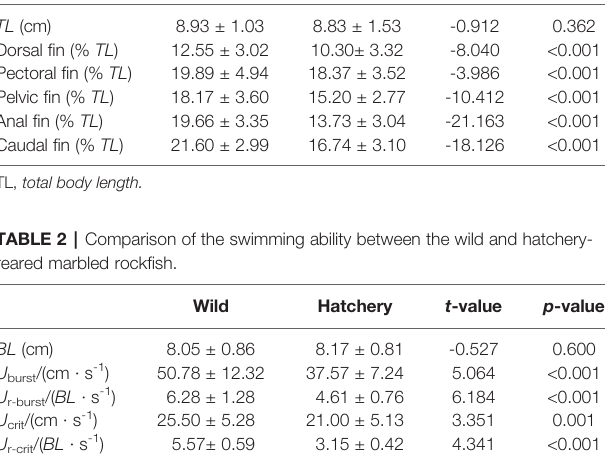
TABLE 3 | Comparison of the whole-body biochemical composition between the wild and hatchery-reared marbled rock fi sh. Content (% body mass) Wild Hatchery t -value p -value